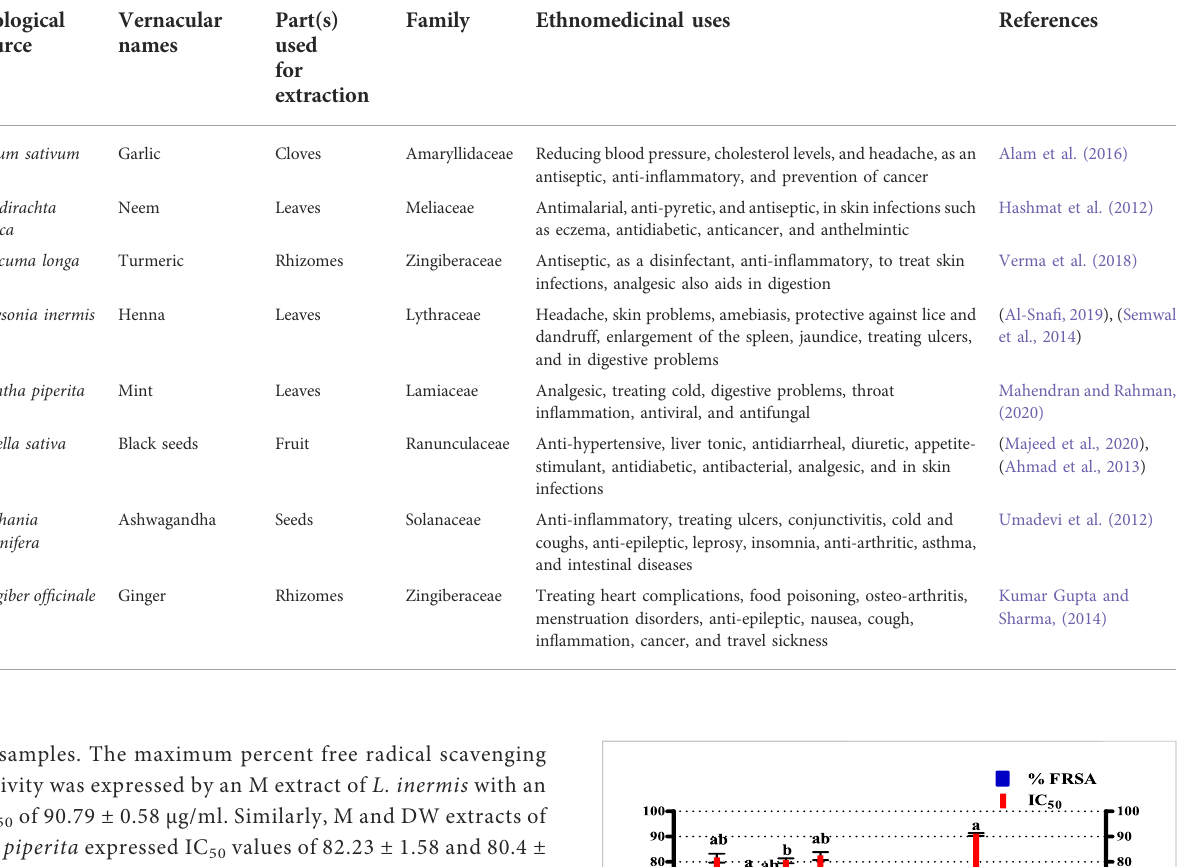
TABLE 2 Selected plants for antifungal screening.